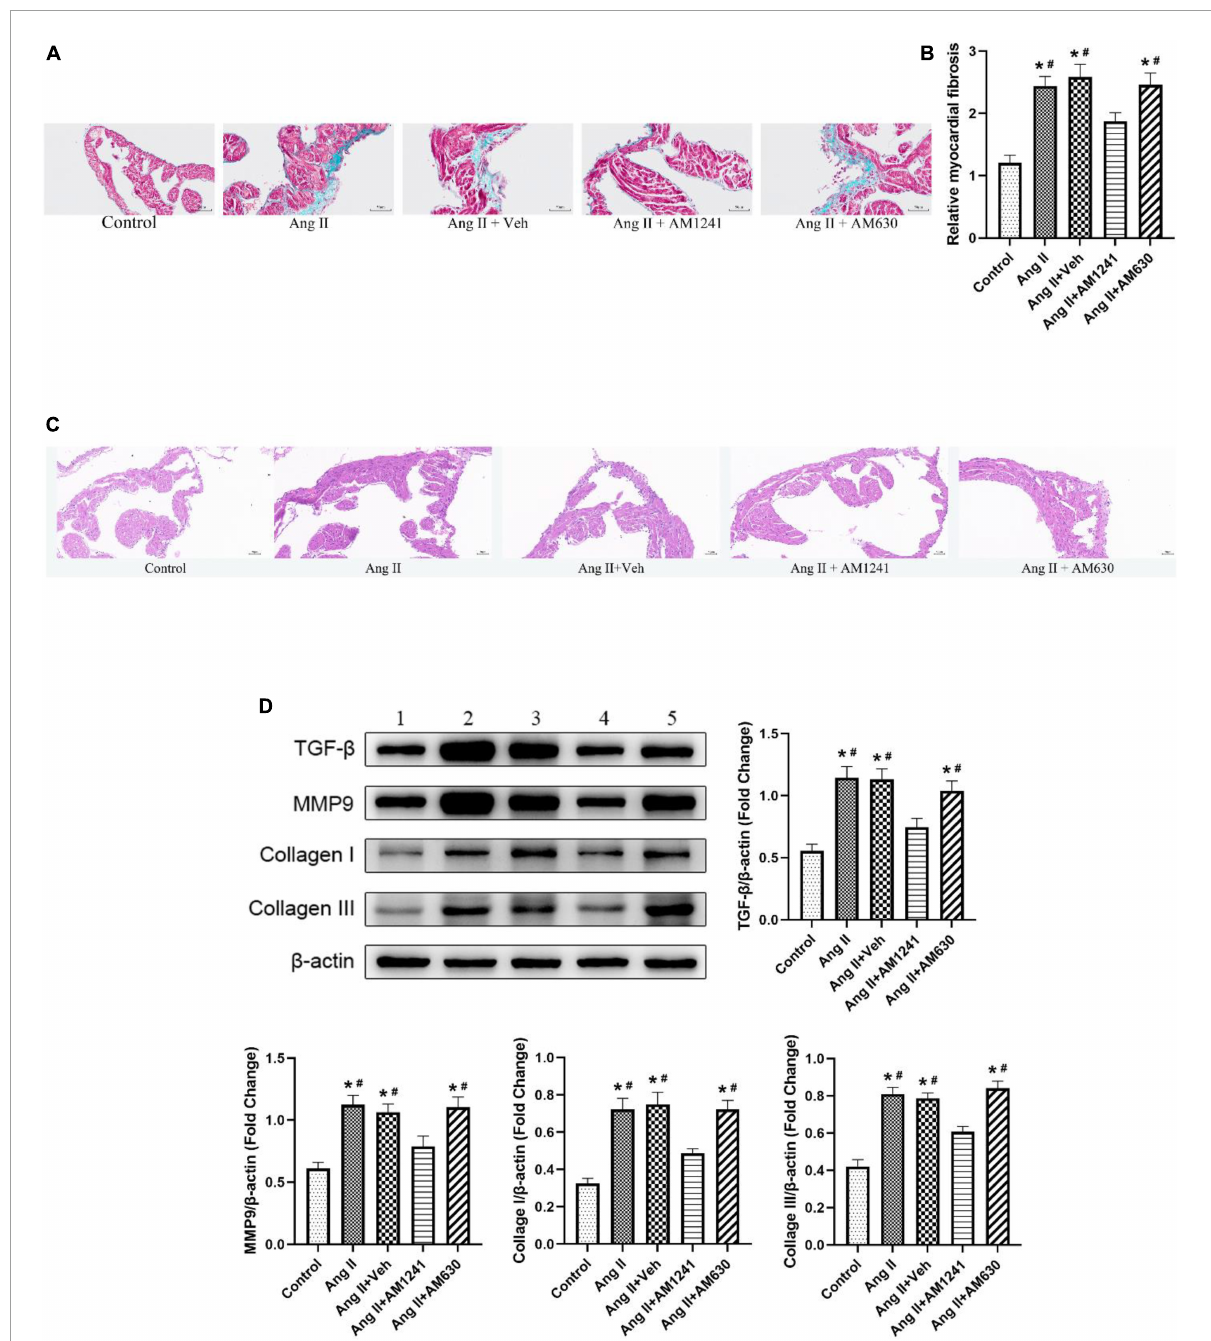
FIGURE5 Administration of AM1241 attenuated atrial fibrosis in Ang II-infused mice. (A) Representative images of Masson’s trichrome staining. Bar = 50 µ m. (B) Relative myocardial fibrosis. (C) Representative images of H&E staining. Bar = 50 µ m. (D) Representative western blot image and relative expression of TGF- β , MMP9, collagen I and collagen III. Lane 1: control group; Lane 2: Ang II group; Lane 3: Ang II + Veh group; Lane 4: Ang II + AM1241 group; Lane 5: Ang II + AM630 group. The data represent the mean ± SEM. * P < 0.05 vs. control group. # P < 0.05 vs. Ang II + AM1241